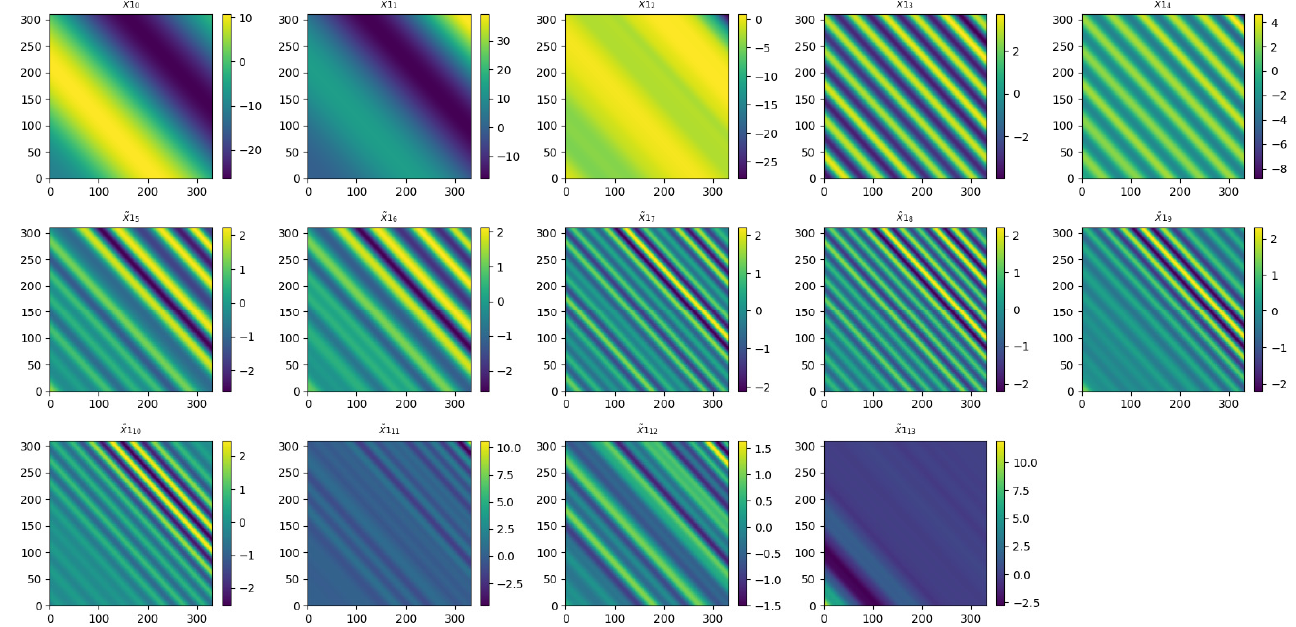
Figure 6. The Hankelized matrices of principal component.